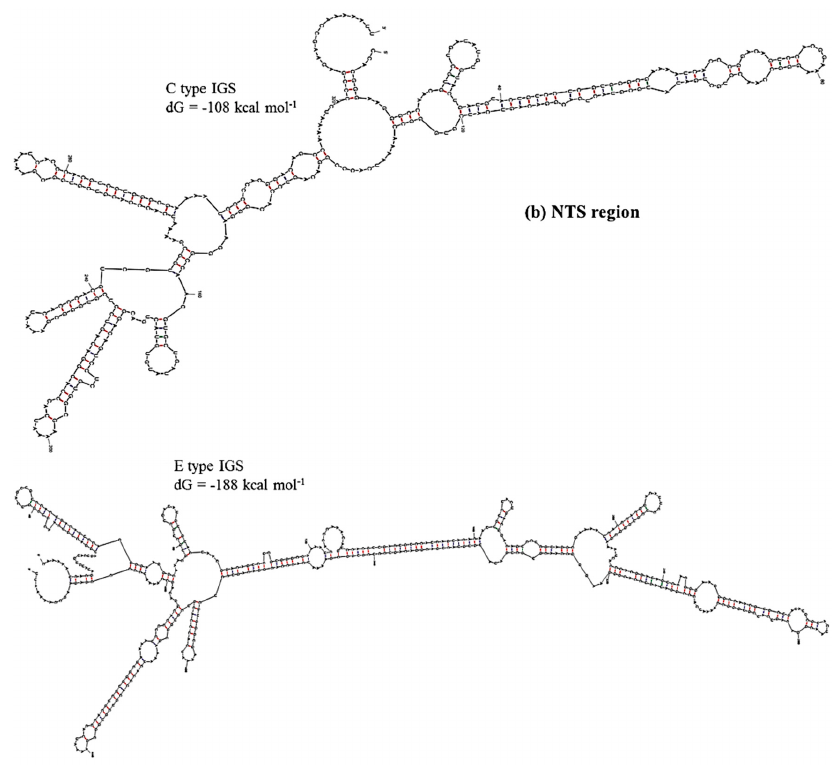
Figure 6. Predicted secondary structures of ( a ) TTS and adjacent region (Region 1) and ( b ) NTS region (Region 2) of C and E type 45S IGS of B. oleracea var. capitata and their minimum free